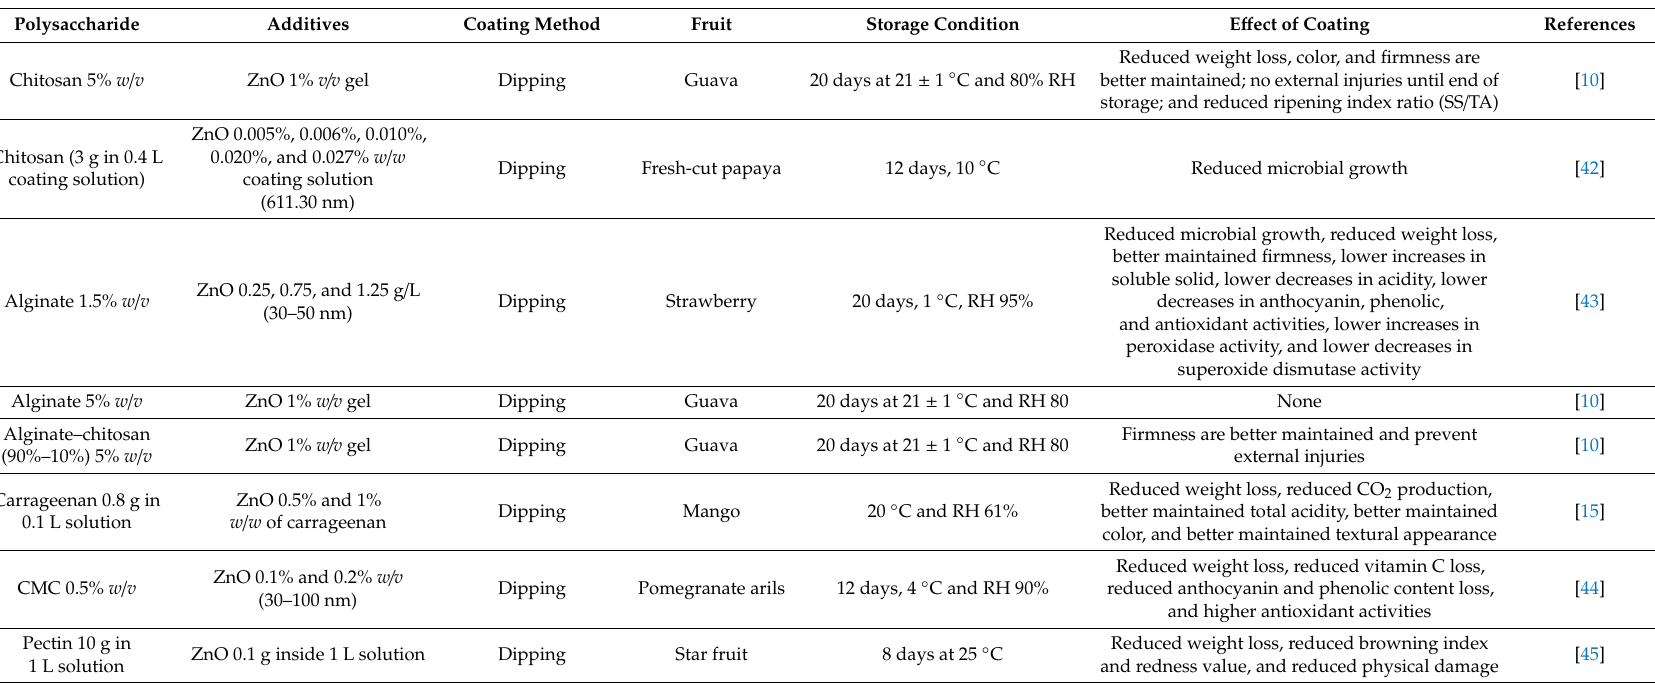
Table 1. Summary of recent studies in the polysaccharide-ZnO safe